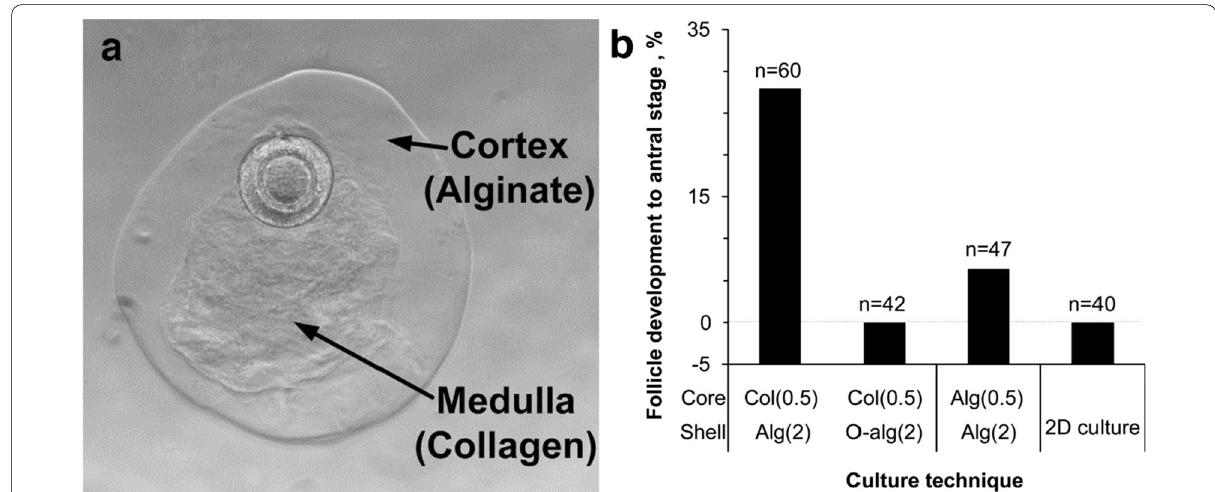
Fig. 2 Collagen-encapsulated follicle. a Micrographs of an early secondary preantral follicle encapsulated in a collagen core with an alginate shell. b Quantitative data shows the effect of the core (0.5% collagen) and shell (2% non-oxidized alginate) materials is the highest. Collagen (Col), alginate (Alg), oxidized-alginate (O-alg). Reproduced with permission from